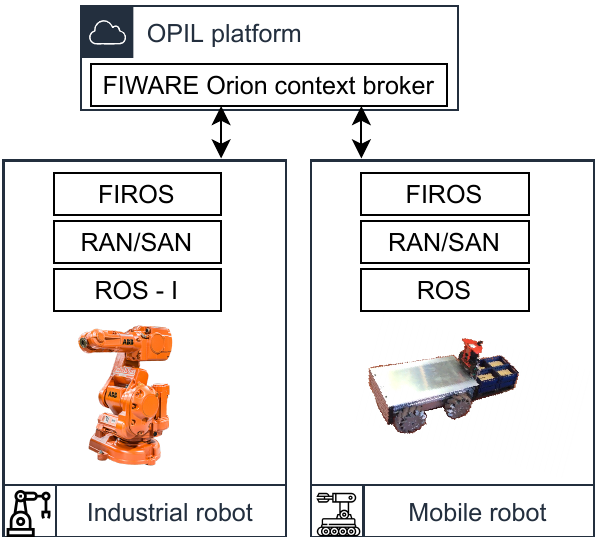
Figure 9. System architecture of robots integration with OPIL